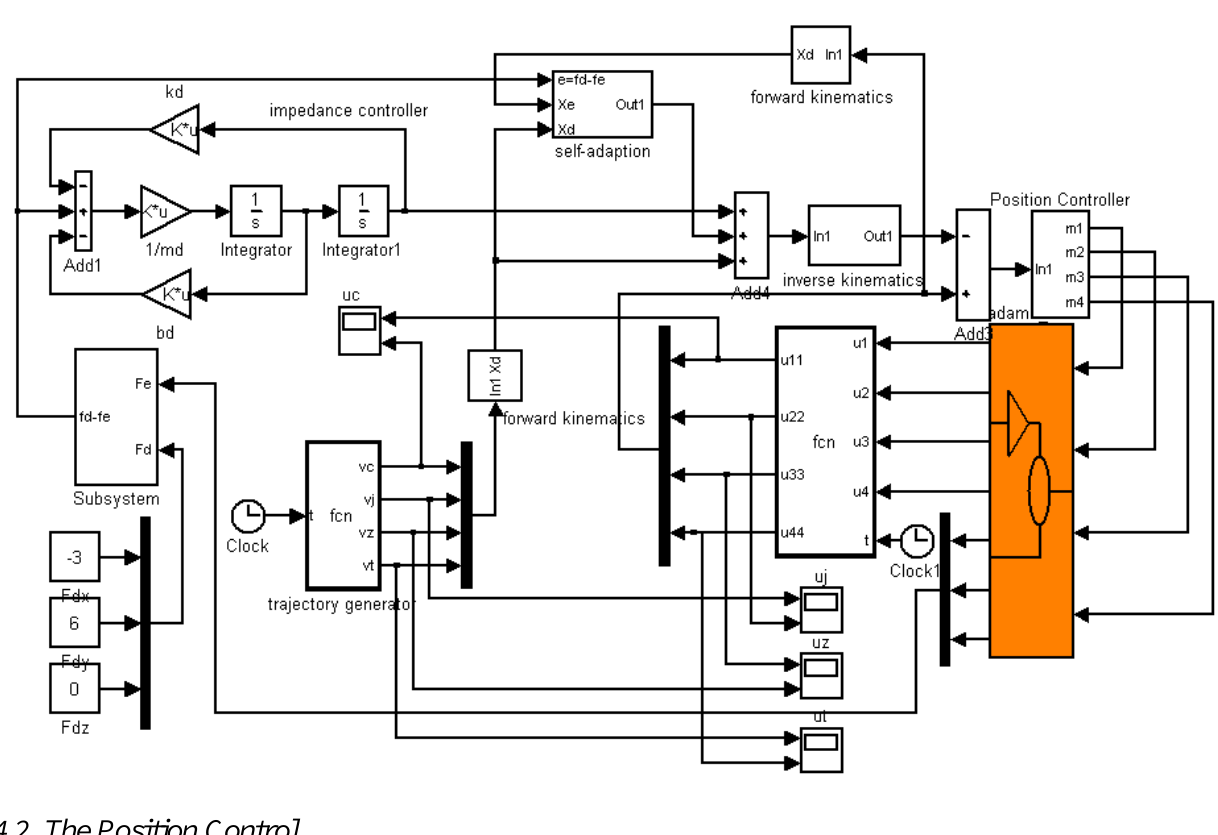
Figure 9. The Control system built in MATLAB.